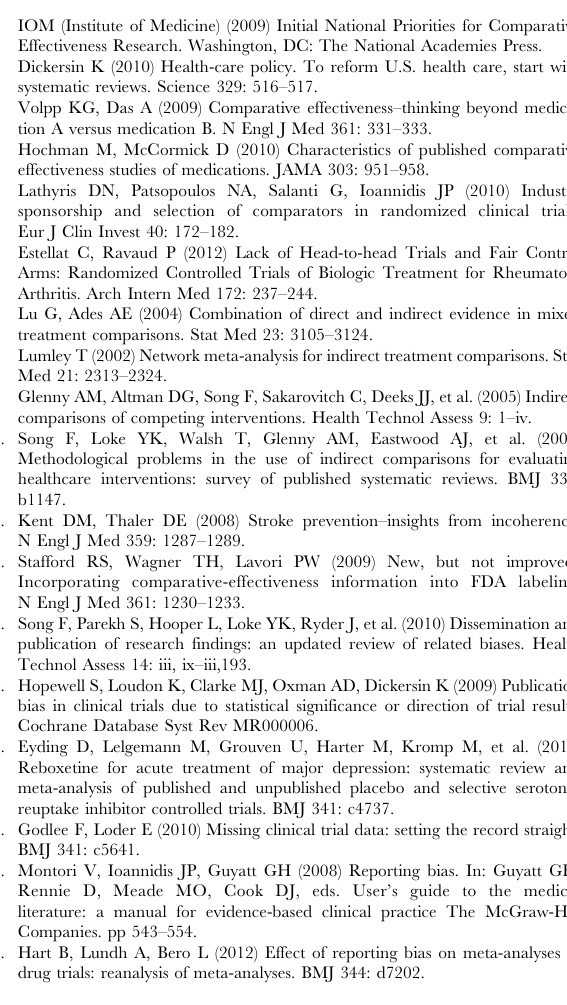
Figure S1 Contour-enhanced funnel plots for the 12 compar- isons between antidepressant agents and placebo.